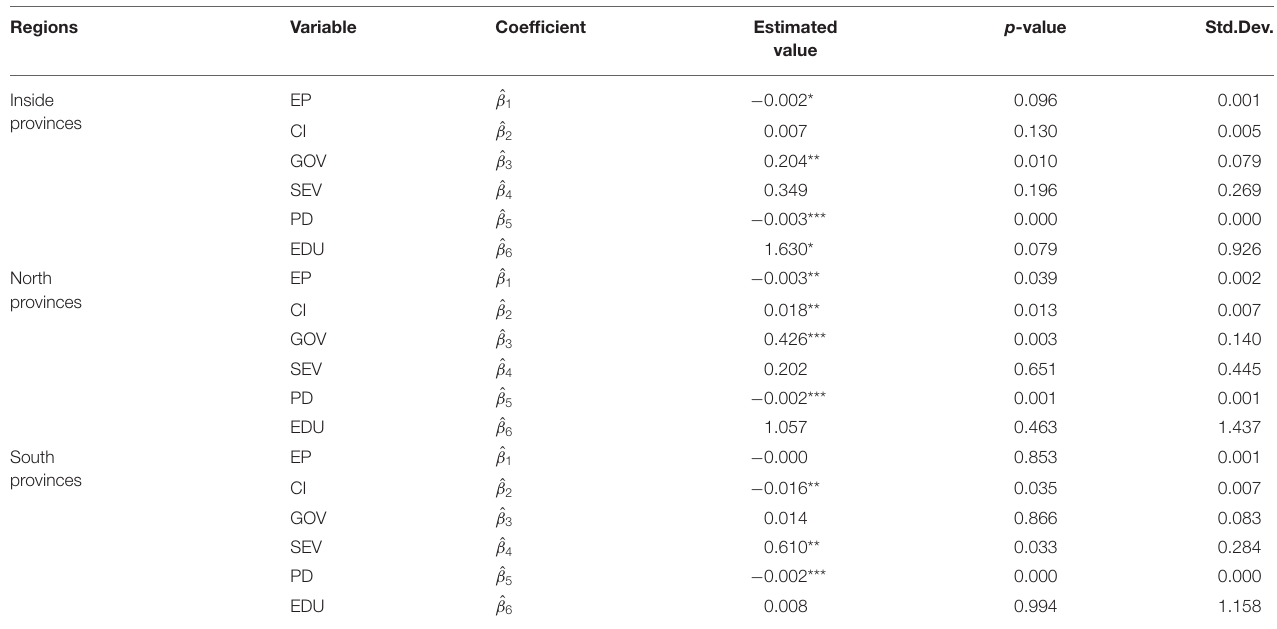
TABLE 5 | Estimated coefficients of the control variables. Regions Variable Coefficient Estimated